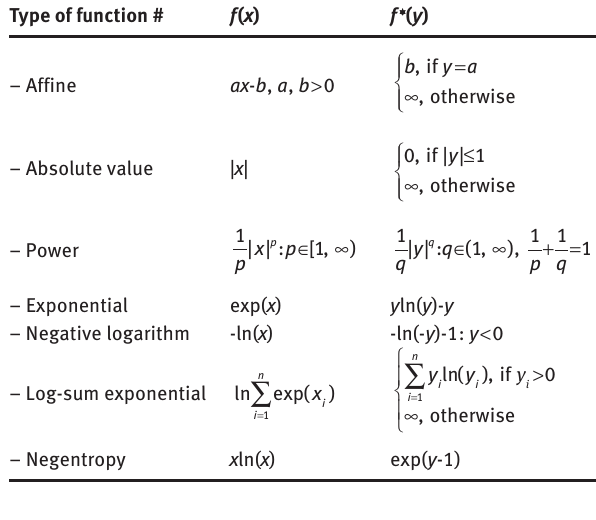
Table 1: Usual conjugacy transformations.